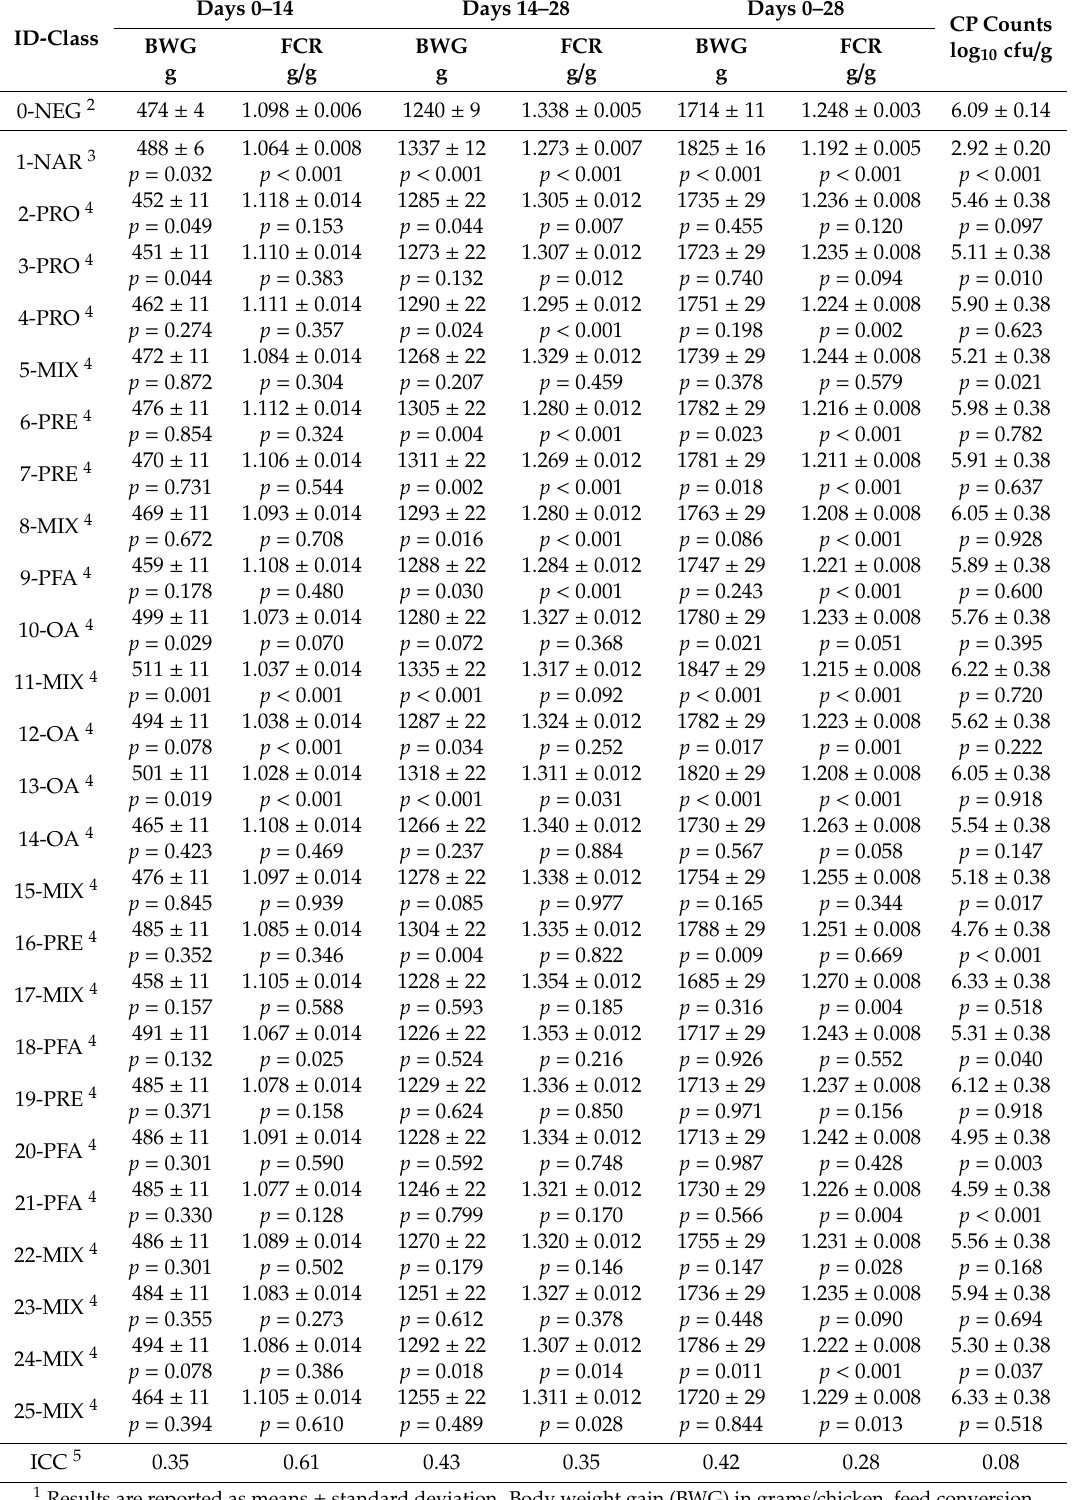
Table 5. Body weight gain, feed conversion ratio and Clostridium perfringens counts for negative control, narasin and alternatives to antibiotics treatments 1